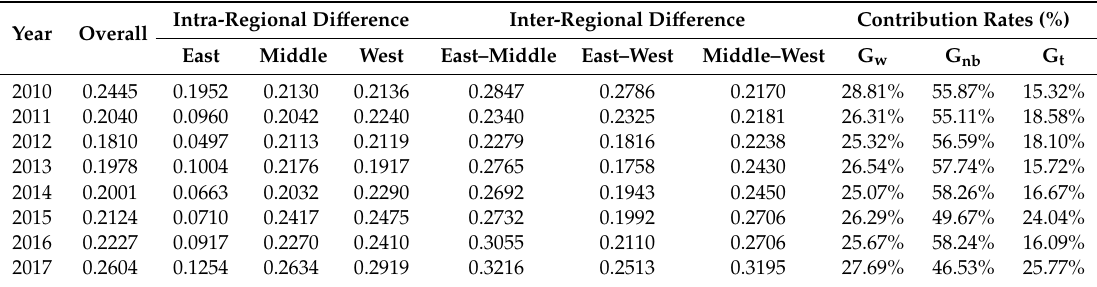
Table 5. The Dagum Gini coe ffi cient and its decomposition